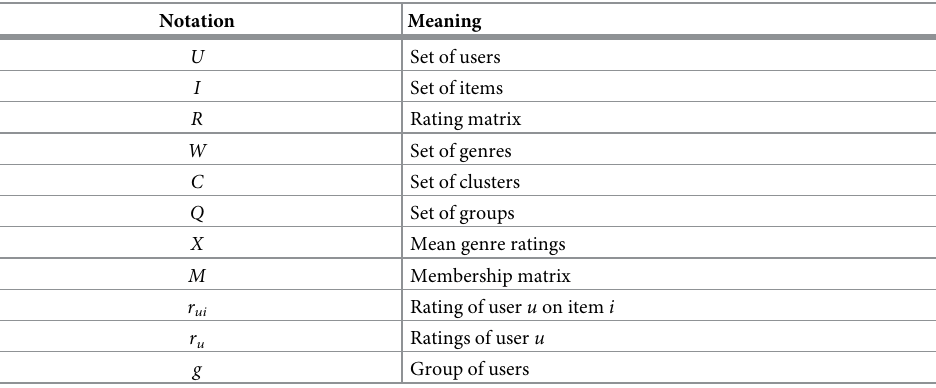
Table 2. Notations and their